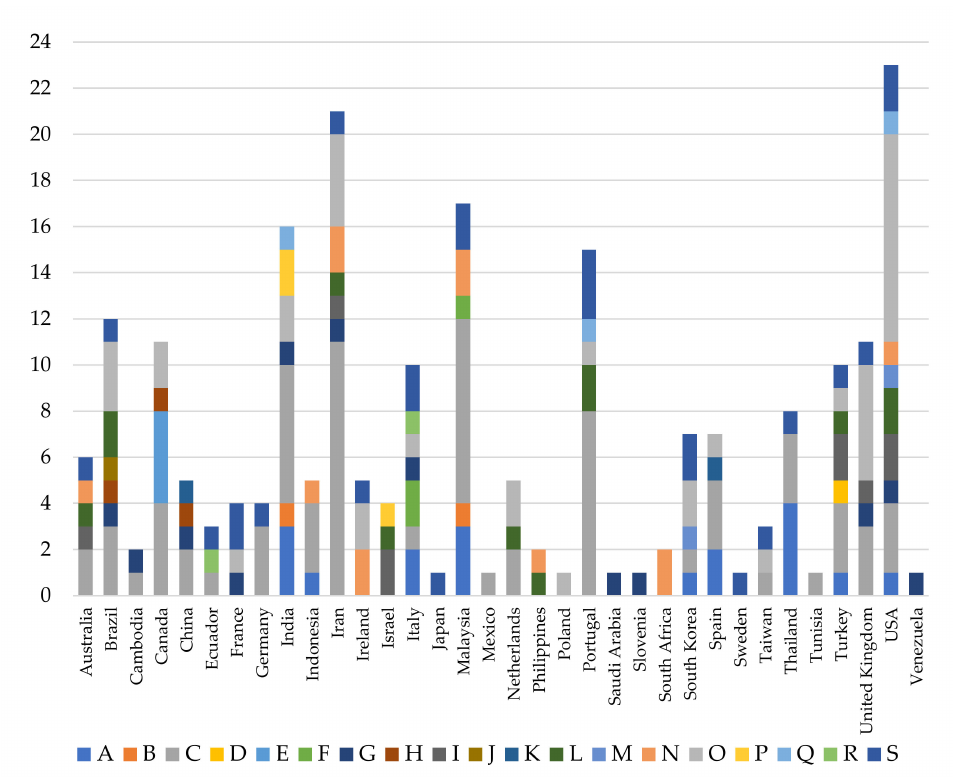
Figure 5. Number of studies classified by knowledge categories and countries: Agriculture, forestry and fishing ( A ); Mining and quarrying ( B ); Manufacturing ( C ); Water supply; sewerage, waste management and remediation activities ( D ); Construction ( E ); Wholesale and retail trade; repair of motor vehicles and motorcycles ( F ); Transportation and storage ( G ); Accommodation and food service activities ( H ); Information and communication ( I ); Financial and insurances activities ( J ); Professional, scientific and technical activities ( K ); Administrative and support service activities ( L ); Public administration and defiance; compulsory social security ( M ); Education ( N ); Human health and social work activities ( O ); Arts, entertainment and recreation ( P ); Other service activities ( Q ); Activities of households as employers; undi ff erentiated goods and services producing activities of households for own use ( R ); and Other scopes not previously included ( S